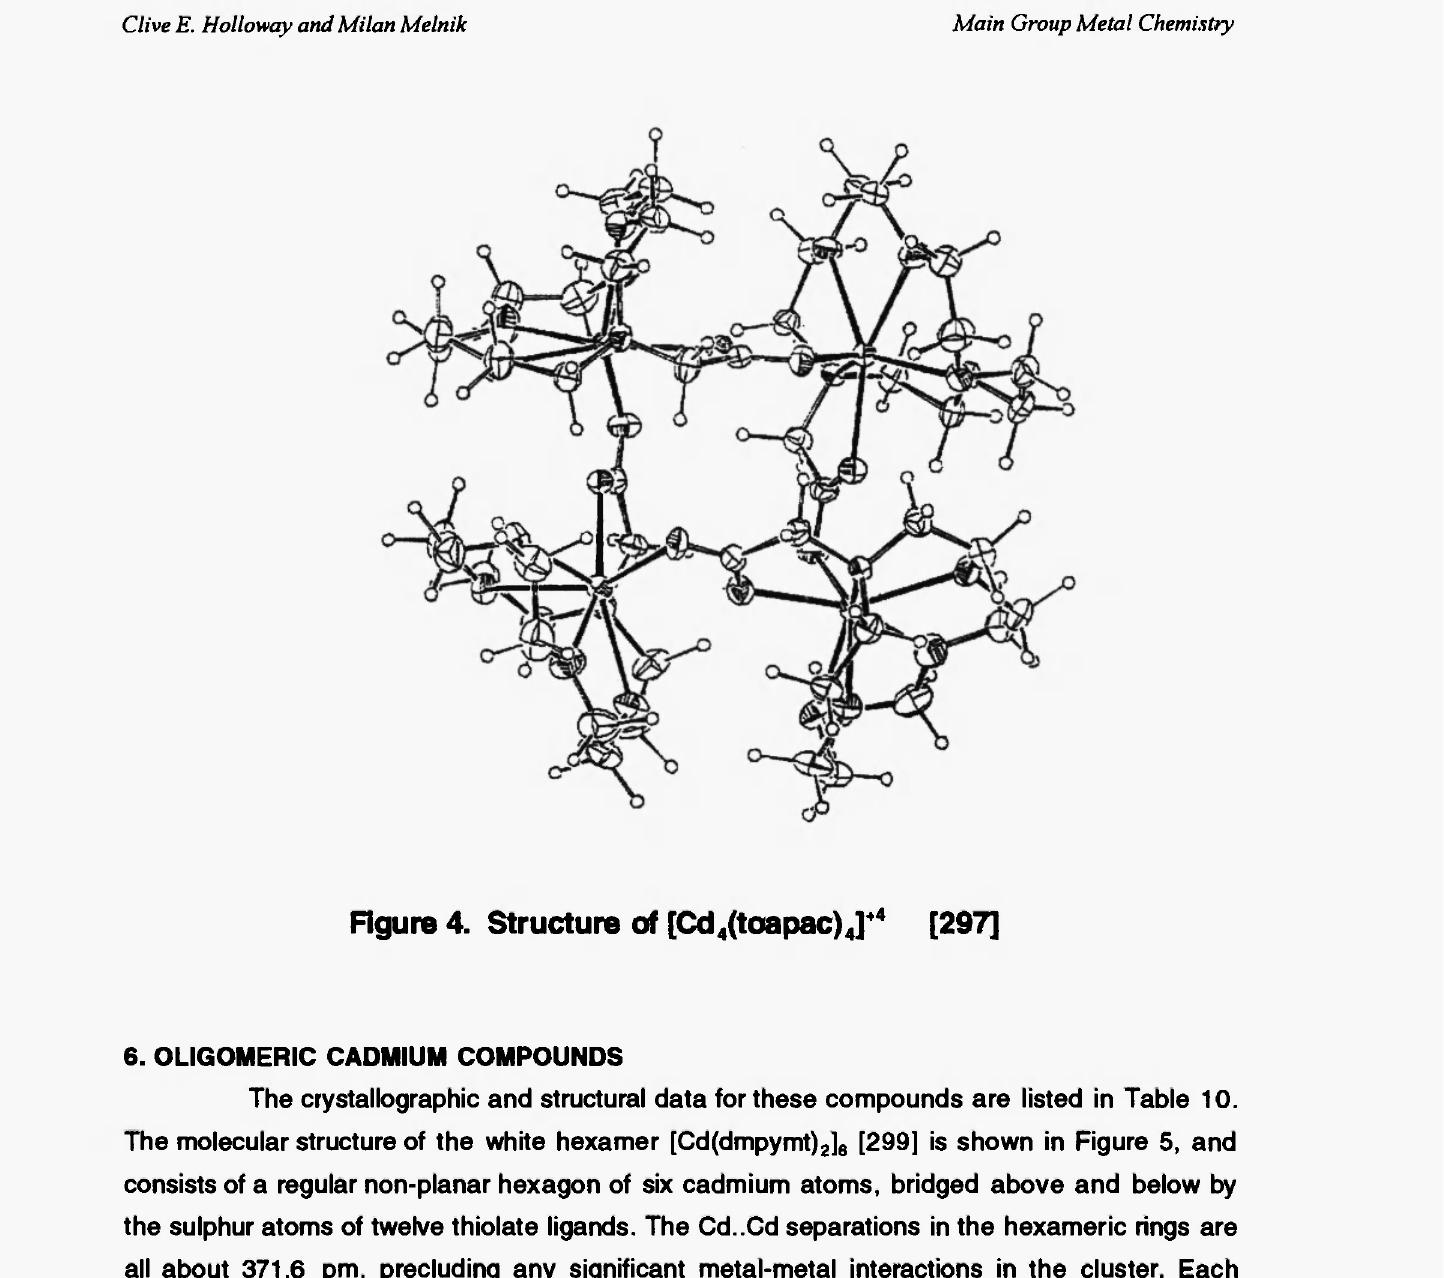
Figure 4. Structure of [Cd